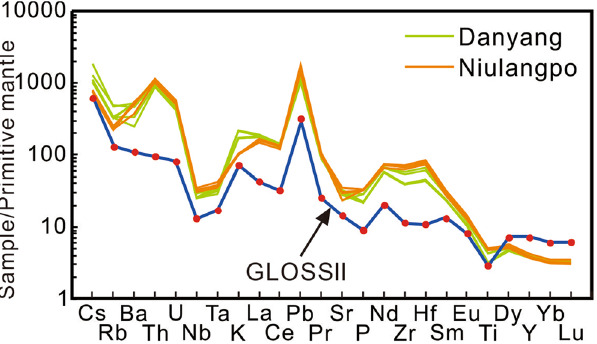
Figure 2. Primitive mantle normalized multi-element variation diagram of the investigated lamprophyres. The normalization values for primitive mantle are from Taylor and McLennan 49 . The composition of the global average of subducted sediment (GLOSS II) is from Plank 9